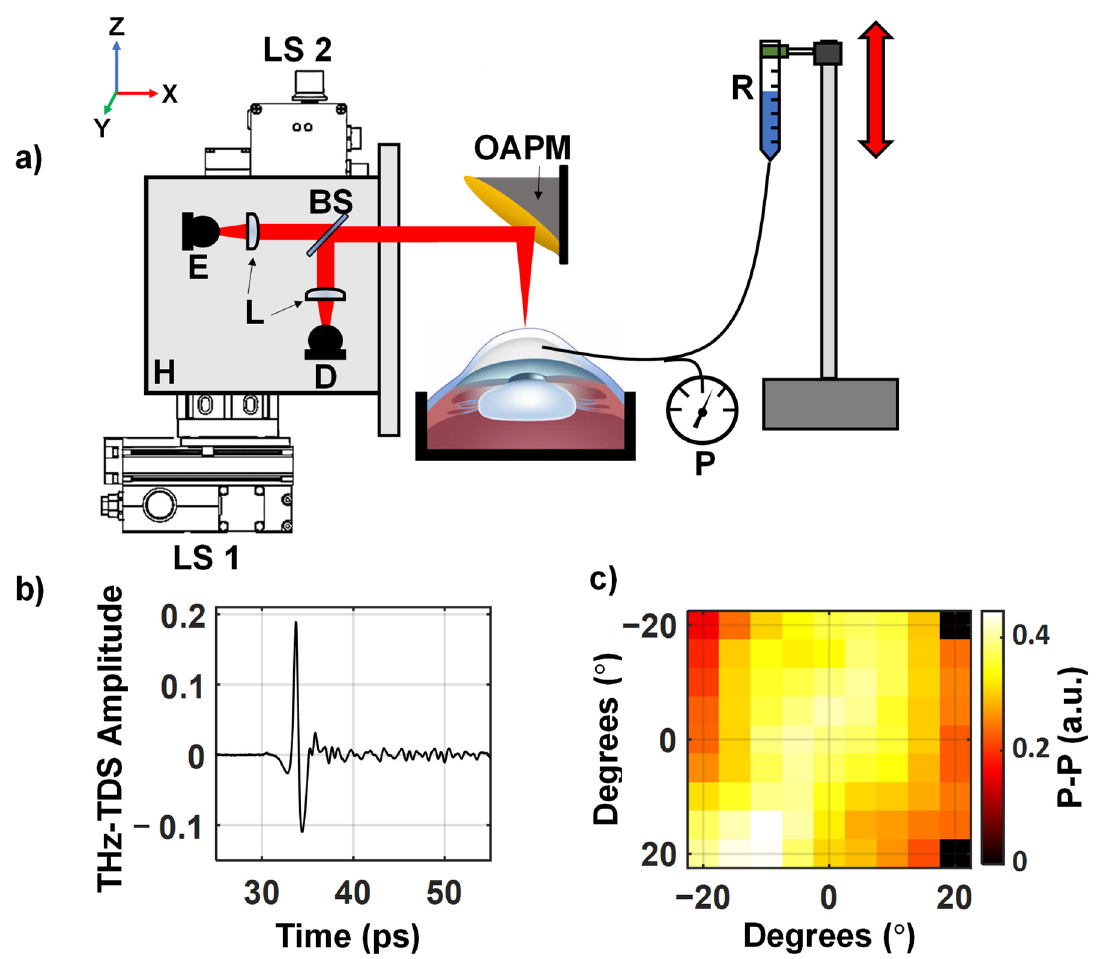
Figure 2. ( a ) A schematic of the setup used in this study. It is similar to one used in a prior ex vivo cornea study [40]. E, emitter; D, detector; BS, silicon beam splitter; R, saline reservoir; L, collimating and focusing lenses (f = 50 mm); P, Pressure sensor; OAPM, off-axis parabolic mirror; H, 3D-printed housing containing the imaging optics, mounted on the LS1 and LS2, linear stage motors, used to move the housing. The red beam shows the path of the THz beam through the setup. ( b ) A representative THz-TDS signal recorded from the center of the corneal sample. ( c ) A raster scan of the corneal sample formed using the peak to peak of the reflected THz pulse.